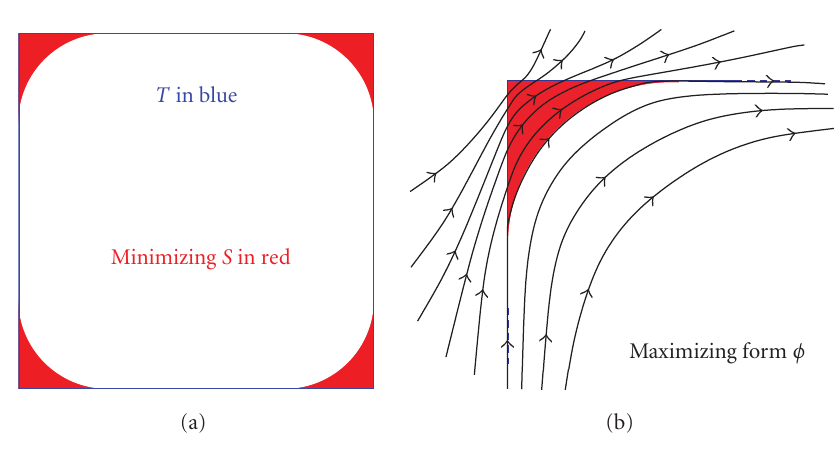
Figure 3.3. Example of a maximizing form for a square T as input. On the right-hand side of the figure, details of the form are shown. We visualize the form as a vector field. On T − ∂S , | φ | = 1 everywhere and on S (red), | dφ | = 1 everywhere, while o ff of these sets, both | φ | < 1 and | dφ | <